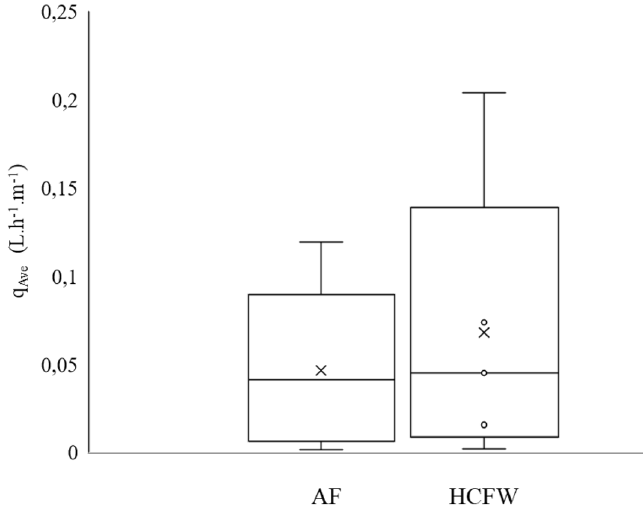
Figure 4. Box plot showing discharge variations between the two types of effluents.